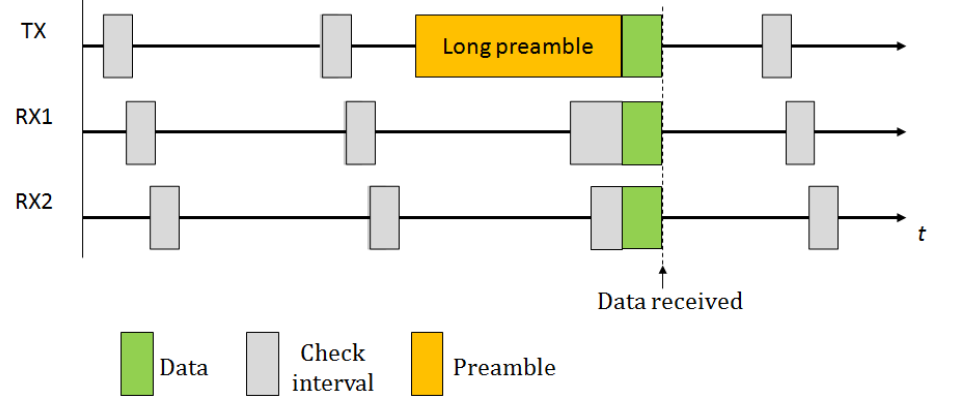
Figure 1. Basic preamble sampling